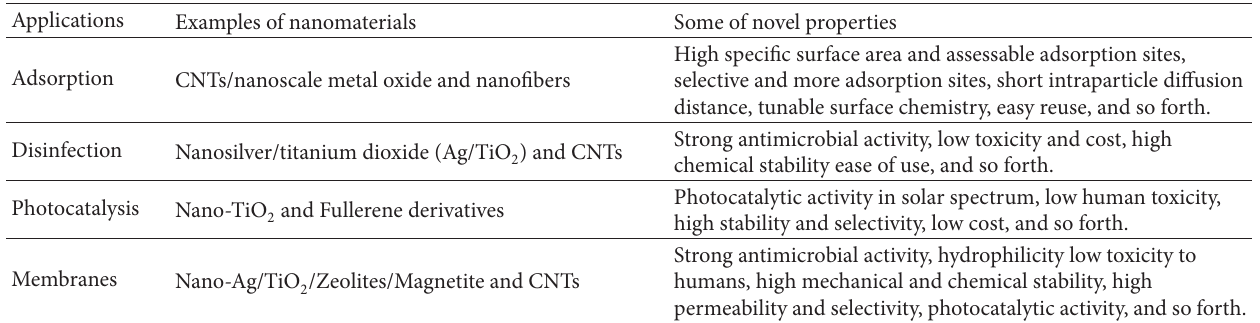
Figure 1: A size comparison of nanoparticle with other larger-sized materials. Table 1: Examples of potential applications of nanotechnology in water/wastewater